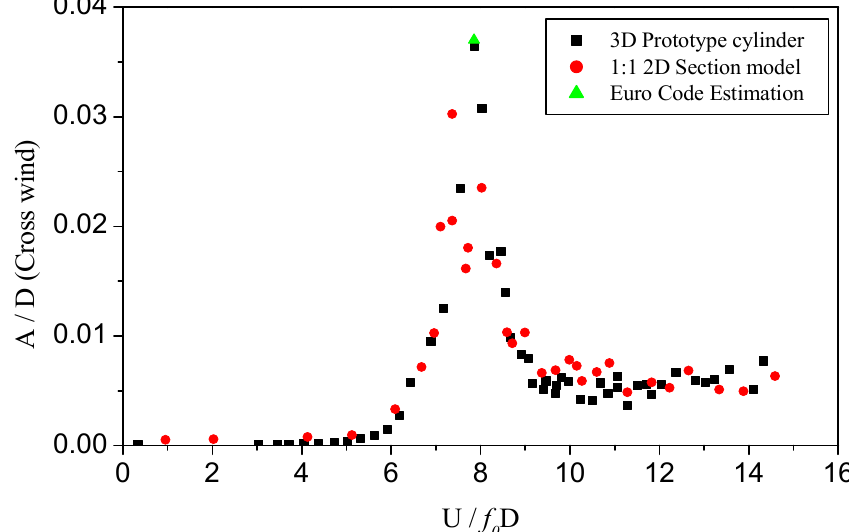
Figure 10. The comparison of the maximum amplitude response between the 3D prototype prism and the 2D section model.